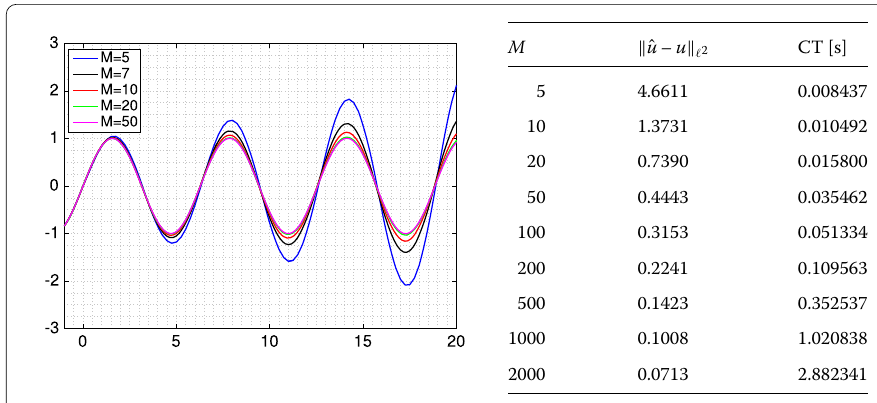
Figure 9 Numerical solutions of (16) using Pouzet-type SSPRK3 and different M ’s calculated on a computer with the specification: Mac OSX 10.14, Processor 2.2 GHz, RAM 8 GB, Matlab 2015b. CT stands for computation time. A short observation indicates that the error accumulate as time